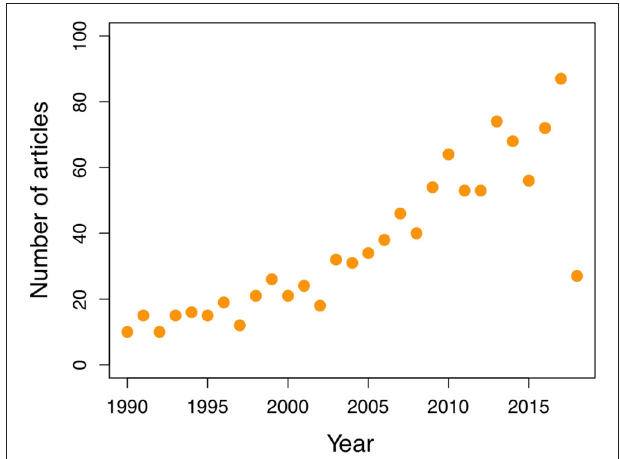
FIGURE 5 | The number of studies on aposematism has been increasing over the last three decades. See text for details on data used.